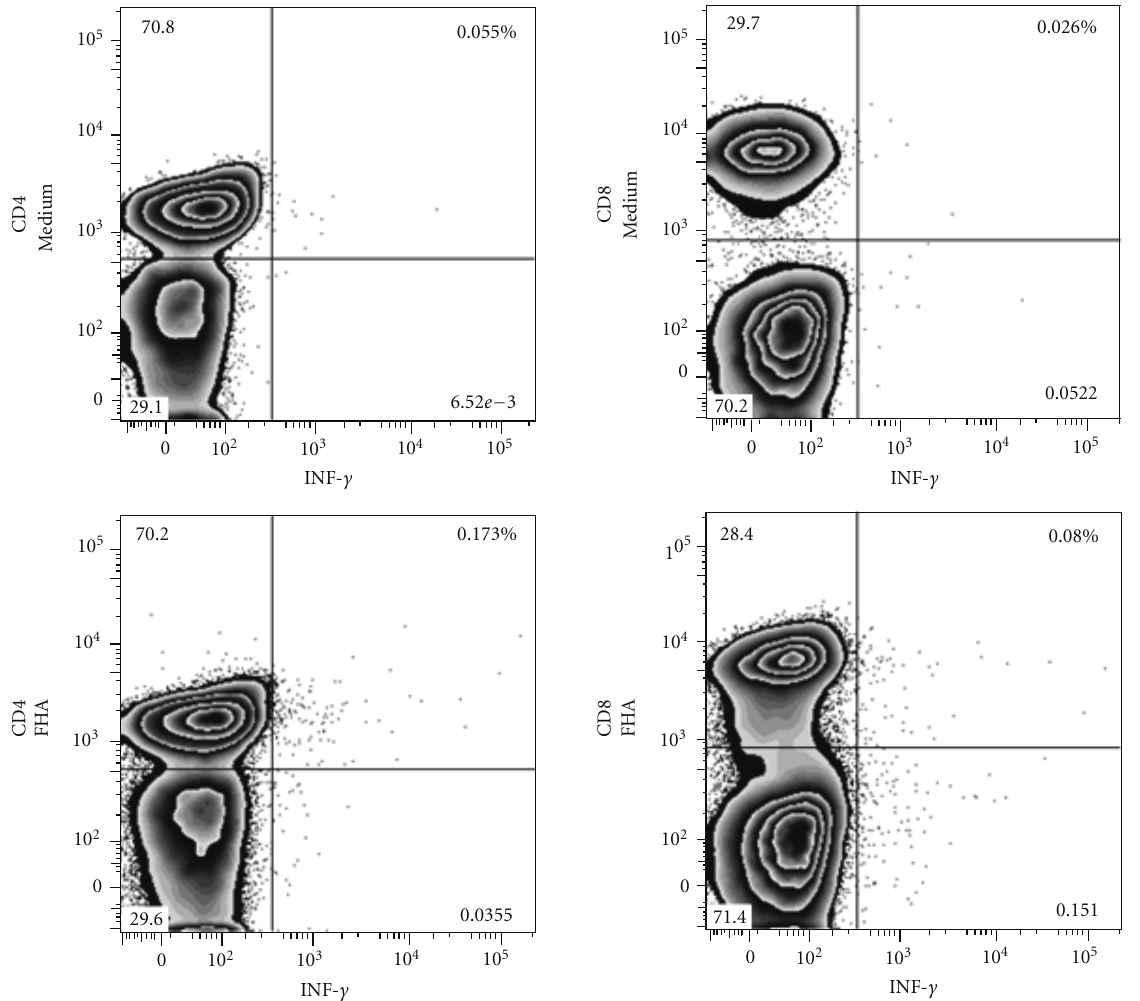
Figure 3: Dot-plot of the flow cytometric analyses of the phenotype of FHA-induced IFN- γ producing cells for one representative subject. Isolated PBMC were cultured in vitro for 24 h in the presence (lower panels) or absence (upper panels) of FHA. CD4 + T cells (left panels) or CD8 + T cells (right panels) were gated in the CD3 + T lymphocytes. Results are expressed as the percentages of IFN- γ producing cells among the cell subpopulation